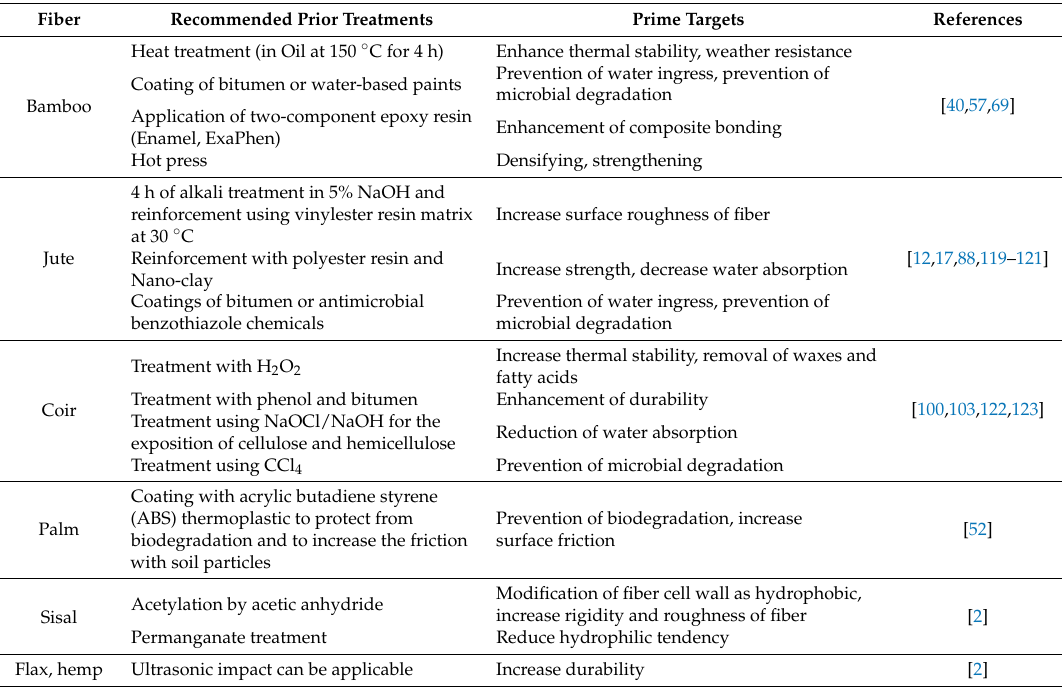
Table 5. Summary of recommended treatments to natural fibers prior to soil